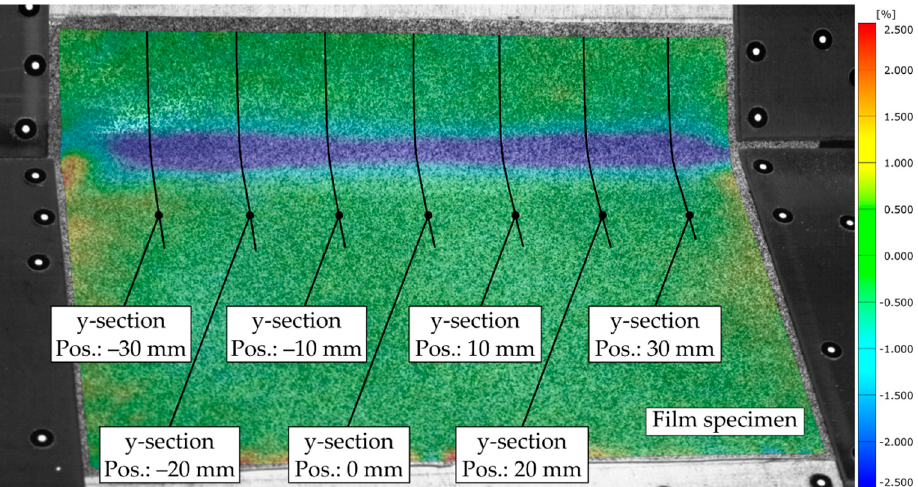
Figure 8. TPU-0.3 film at the time step after completion of the bending procedure showing the distribution of mechanical y-strain and the position of the y-sections enabling the identification of the bending area (test No. 9, 𝑡 = 21.5 s).